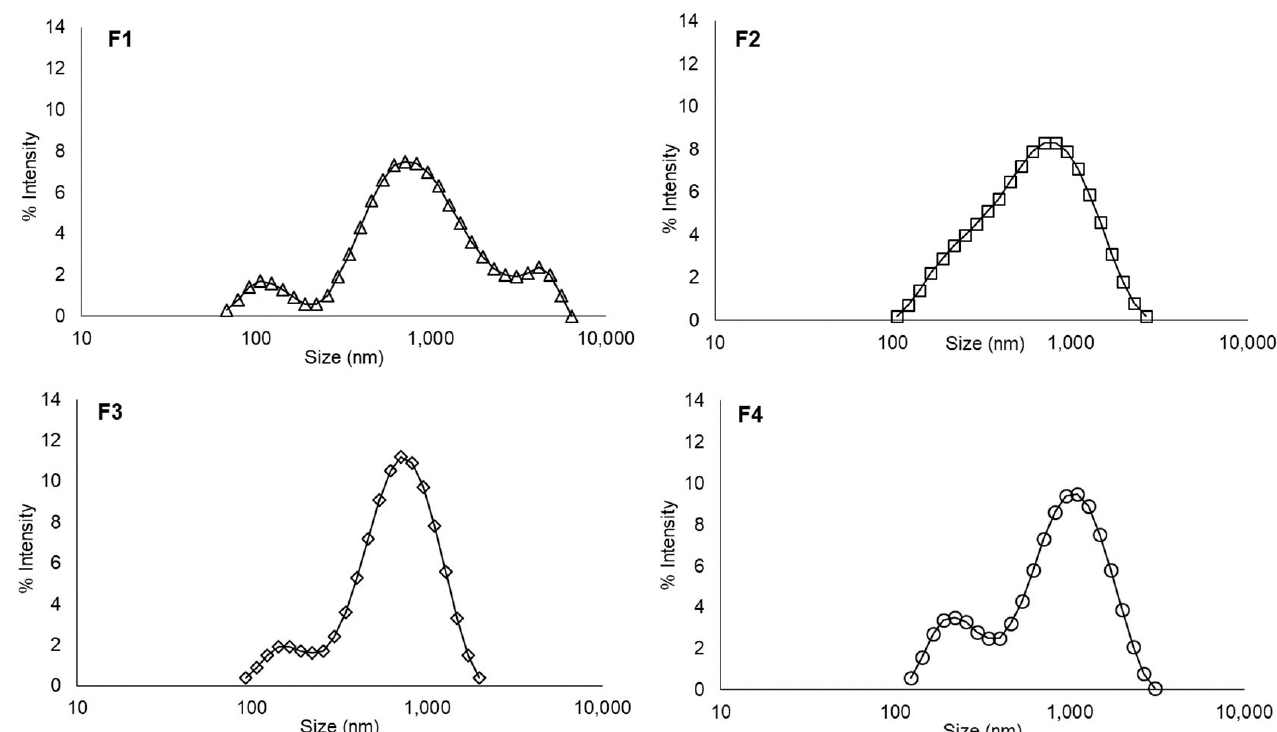
Figure 2. Size distributions of the four formulations of surfactant-polyelectrolyte complexes studied (F1, F2, F3 and F4).